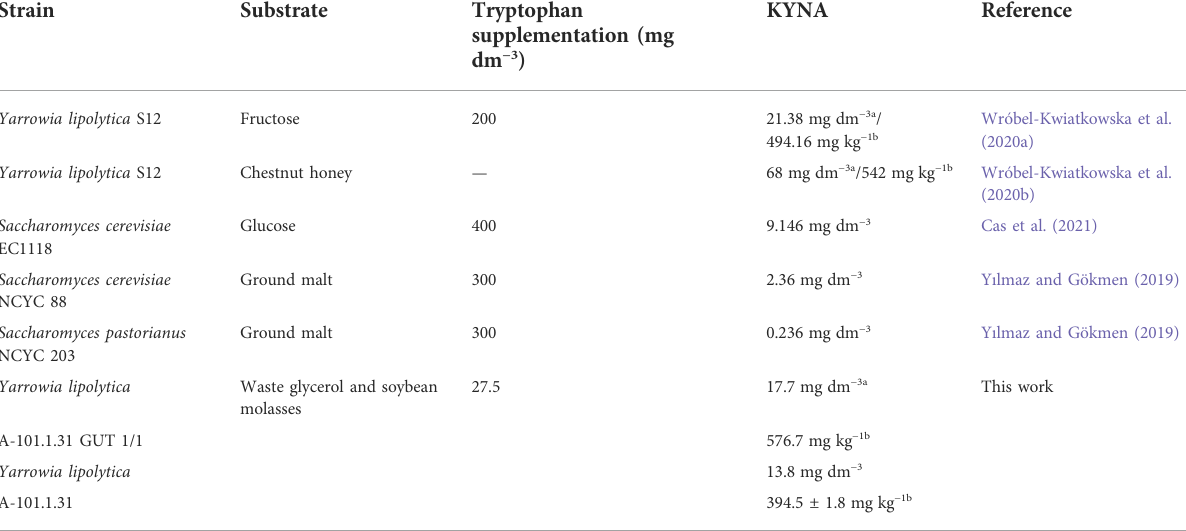
TABLE 5 Comparison of kynurenic acid (KYNA) production by various